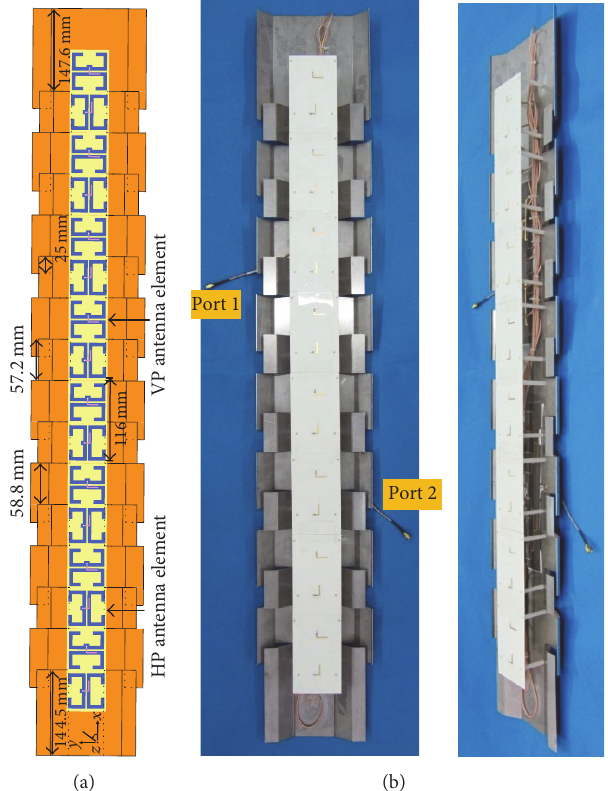
Figure 6: A V/H dual-polarized antenna array: (a) geometry of the antenna array; (b) a prototype of the antenna array.